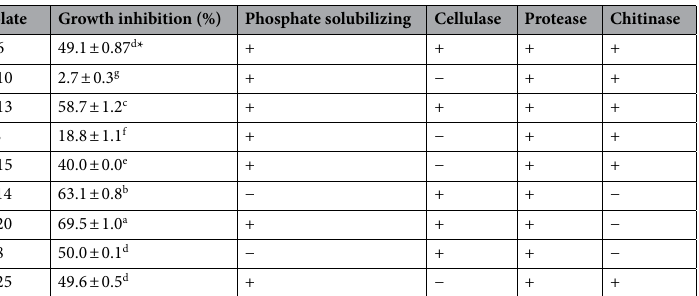
Table 1. In vitro growth inhibition of Phytophthora capsici and hydrolytic enzymes production by Streptomyces isolates. Values are the means (averaged from three replicates) ± SE. *Same letters represent non- significant difference according to Duncan’s Multiple Range Test ( P < 0.05 ). +: Producing −: